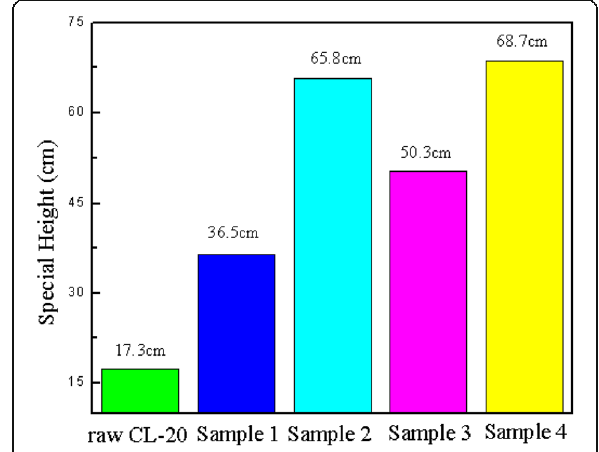
Fig. 5 Impact sensitivity of samples